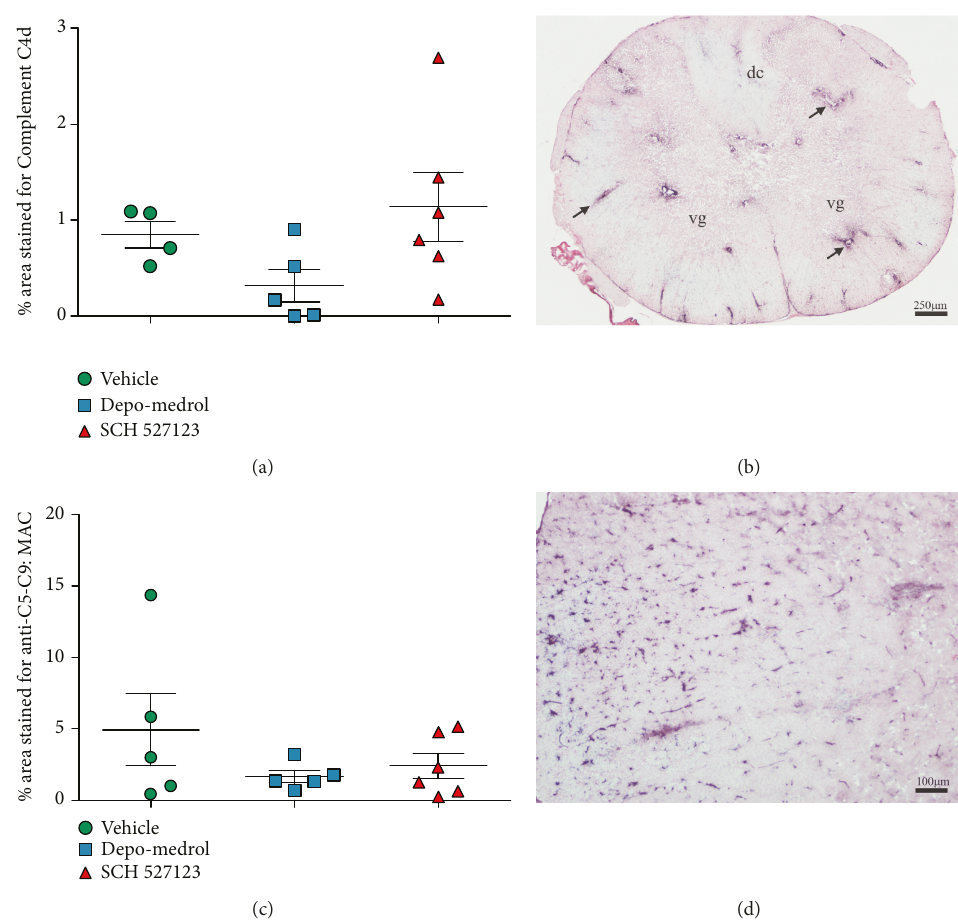
Figure 5: Complement markers are unchanged in NMO rats treated with CXCR2 antagonist, SCH527123. C4d, a marker for activation of the classical complement pathway, showed similar staining patterns in and around spinal cord lesions from rats treated with SCH527123 compared to vehicle control, quanti fi ed (a) with a representative sample (b). Depo-Medrol at 10mg/kg showed lower levels of C4d staining. Staining with anti-C5-C9 was used to assess overall terminal activation of complement pathways. C5-C9 was not signi fi cantly di ff erent among the three groups, quanti fi ed (c) with a representative sample